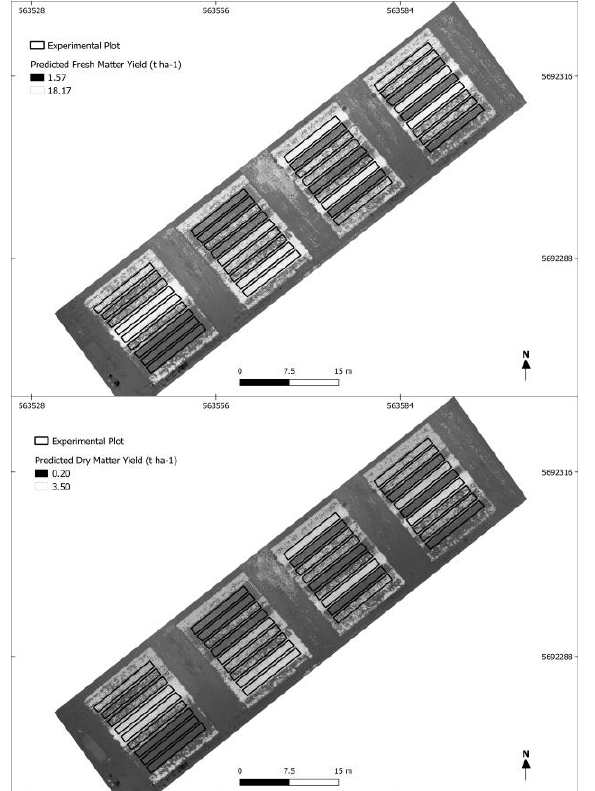
Figure 2: Predicted fresh matter (top) and dry matter yield (bottom) maps for the experimental layout (Grüner et al. 2019) for the second sampling date (June 2018). Predicted values are based on a random forest regression model using spectral reflectance of the green, red, rededge, and NIR bands as well as 14 spectral indices